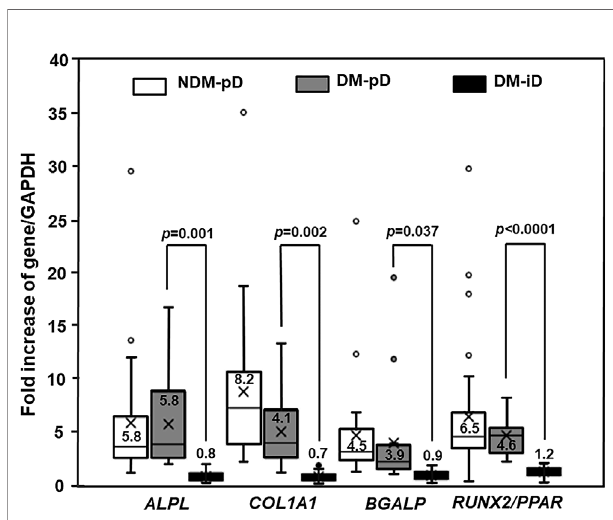
FIGURE 1 | Osteogenic differentiation marker expression. Box and whisker plots to show comparison of osteoblast-speci fi c gene expression in participants without diabetes showing preserved osteogenic differentiation potential (NDM-pD), patients with diabetes showing preserved osteogenic differentiation potential (DM-pD) and patients with diabetes showing impaired osteogenic differentiation potential (DM-iD)(mean ± SD). DM-pD had higher levels of expression of ALPL, COL1A1, BGLAP and RUNX2/PPAR g ratio (RUNX2/PPAR) than those in DM-iD by 7.3, 5.9, 4.3 and 3.8 times, respectively. DM-pD had signi fi cantly higher levels of expression of all osteoblast-speci fi c genes than those in DM-iD but had comparable levels of expression of all osteoblast- speci fi c genes to those in